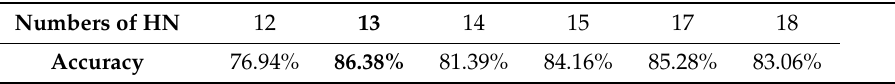
Table 8. Accuracy on testing data in scheme C.